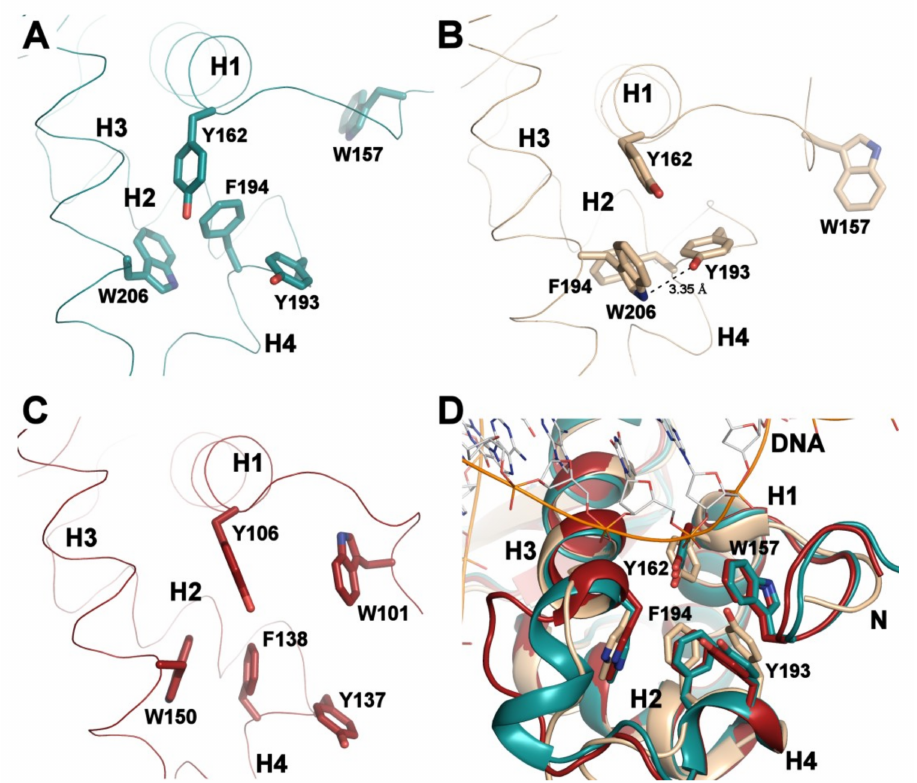
Figure 4. Interactions of hydrophobic residues on the interface between the N-terminal segment, the H2–H3 loop and helix H3. ( A ) Interactions observed in apo FOXO1-DBD (conf. no. 16). ( B ) Interactions observed in apo FOXO3-DBD (conf. #11, PDB ID: 2K86 [46]). ( C ) Interactions observed in apo FOXO4-DBD (conf. no. 3, PDB ID: 1E17 [45]). ( D ) Interactions observed in DNA-bound forms of FOXO1-DBD (PDB ID: 3COA [7], shown in dark cyan), FOXO3-DBD (PDB ID: 2UZK [6], shown in sand) and FOXO4-DBD (PDB ID: 3L2C [8], shown in dark red). For clarity, only DNA in the FOXO1-DBD:DNA complex is